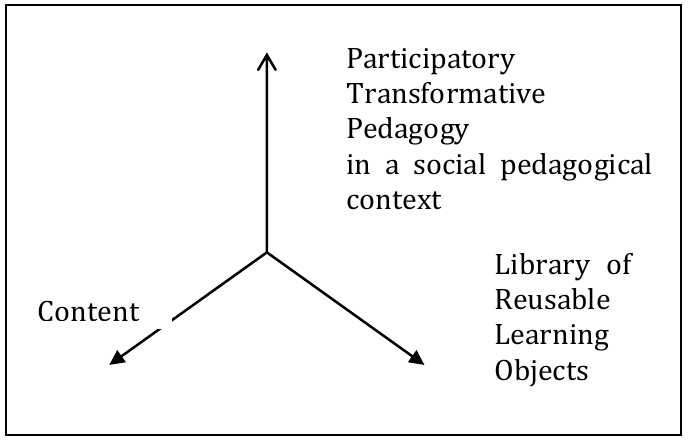
Figure I. The Development